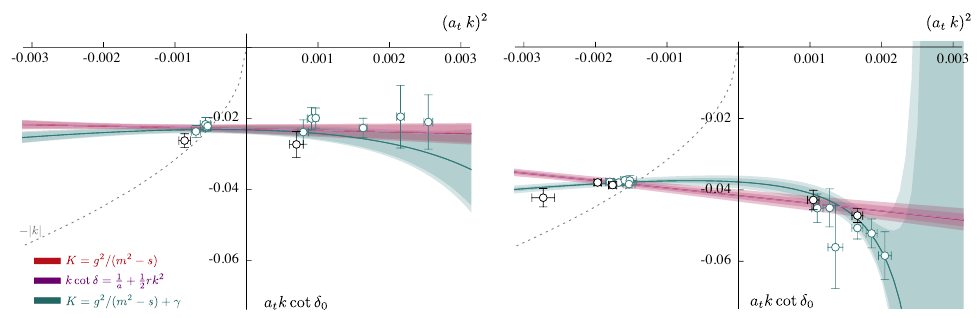
Figure 11 . DK I = 0 S -wave scattering amplitudes, plotted as a t k cot δ ‘ =0 , using the reference (aa), effective range (x) and pole plus constant K -matrix (a) parametrisations for m π = 239 MeV (left) and m π = 391 MeV (right). Black points are determined from energy levels in the [000] A + irrep assuming ‘ > 4 amplitudes are negligible. Blue-green points are from the non-zero momentum A 1 irreps with amplitudes for higher partial waves fixed to